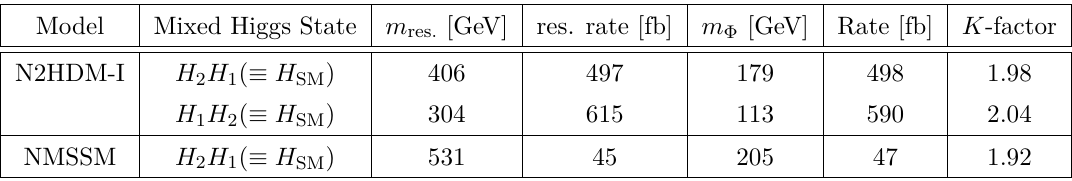
¯ Table 28 . Maximum rates at NLO QCD in the ( b b )( WW ) final state for different mixed Higgs pair final states in the investigated models with the non-SM-like Higgs decaying into WW ; the corresponding K -factor is given in the last column. In case of resonantly enhanced production, we give in the third and fourth column, respectively, the mass of the resonant Higgs boson and the resonant cross section as defined in the text. The fifth column contains the mass of the non-SM-like final state Higgs boson. More details on these points can be provided on request.